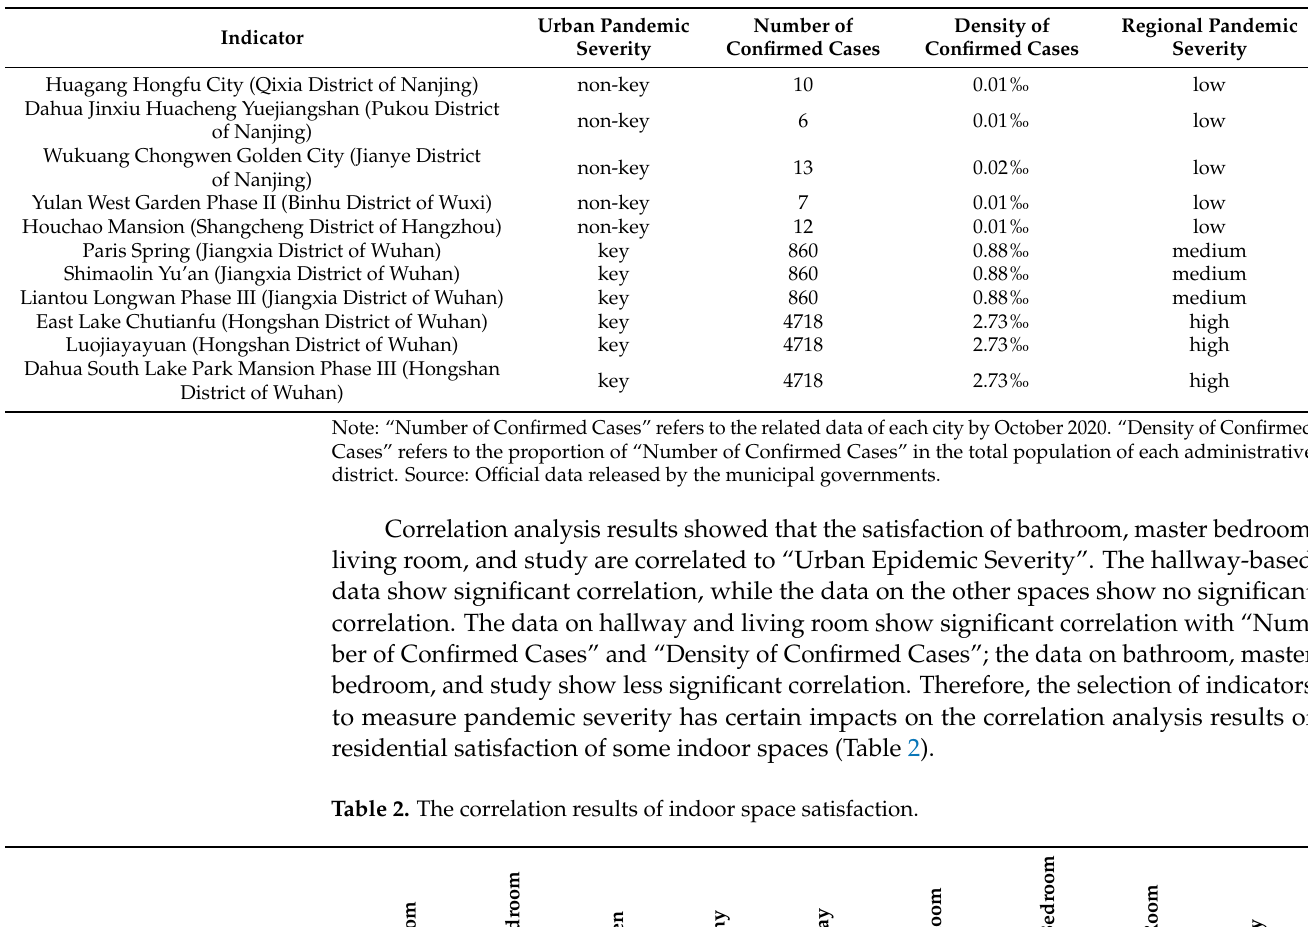
Table 1. The indicators of pandemic severity.